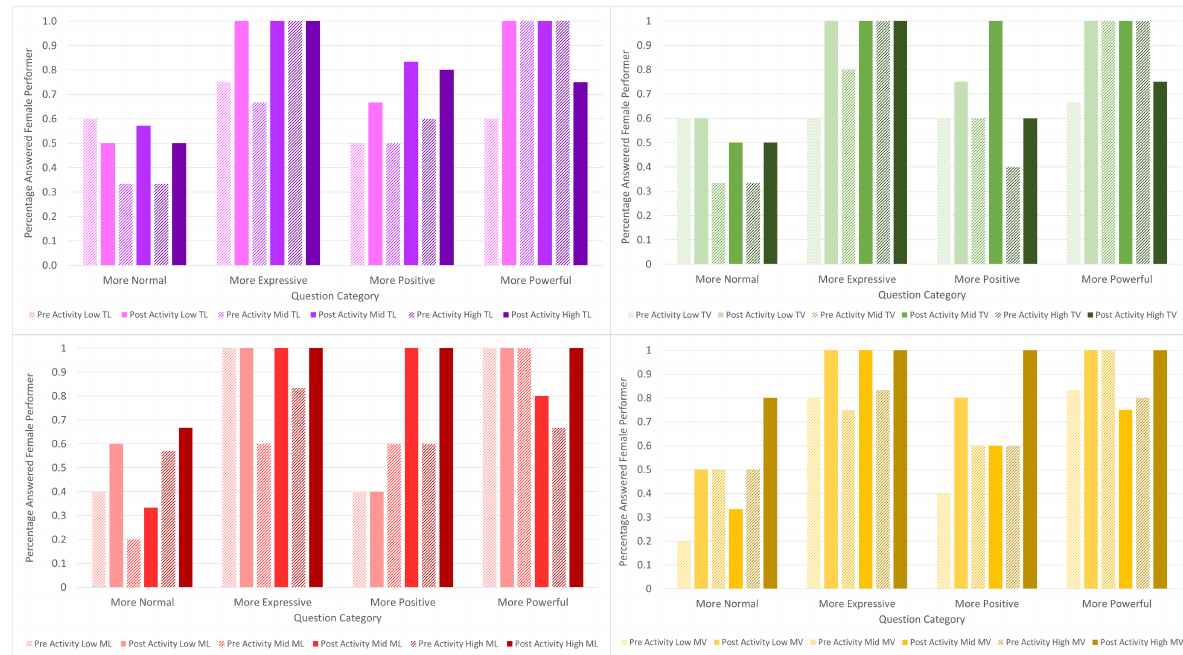
Figure 7: All pairings of Abacus vs. Female Performer, showing how many participants rated Female performer as more normal, more ex- pressive, more positive, and more powerful. These are separated into three levels (Low, Mid, High) of four metrics (Technology Literacy, Technology Valence, Movement Literacy, and Movement Valence). All participants rated Female Performer as more expressive after the ex- perience, regardless of metric category, which may support hypothesis that people who appear in performances are rated as more express (since the same ratings were not found for the Male vs. iPhone pairing). Additionally, Mid-ML and Low-TV participants showed the largest increase in answering Female Performer as more expressive after the experience (bottom left and top right figures here).